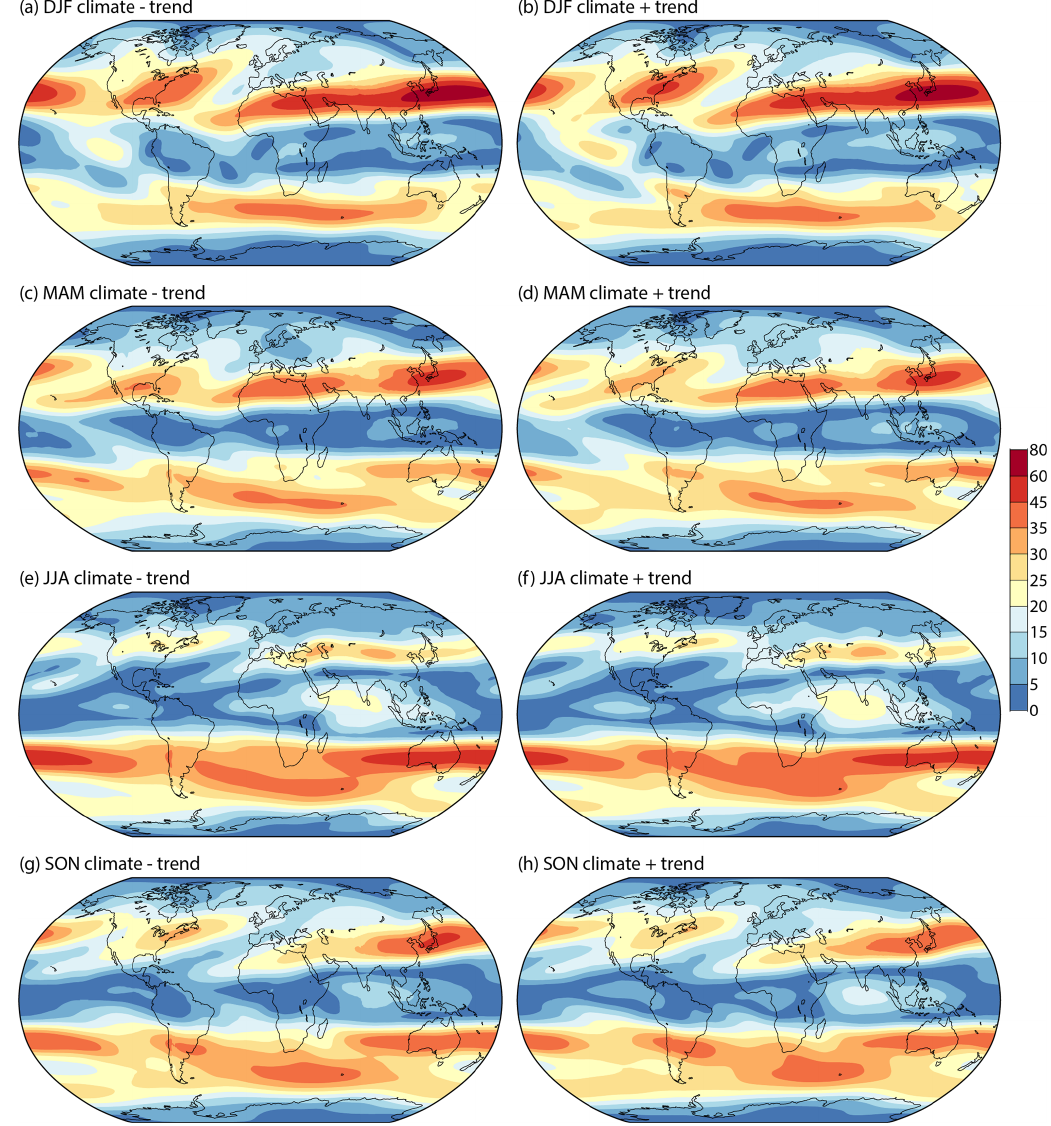
Figure 11. Seasonal 200hPa wind speeds (ms − 1 ) based on subtracting (left) and adding (right) the change over 21.5 years derived from least squares linear fits of seasonal-mean wind components from March 1979 to February 2022 to the average wind components for the period, shown for (a, b) DJF, (c, d) MAM, (e, f) JJA and (g, h) SON.